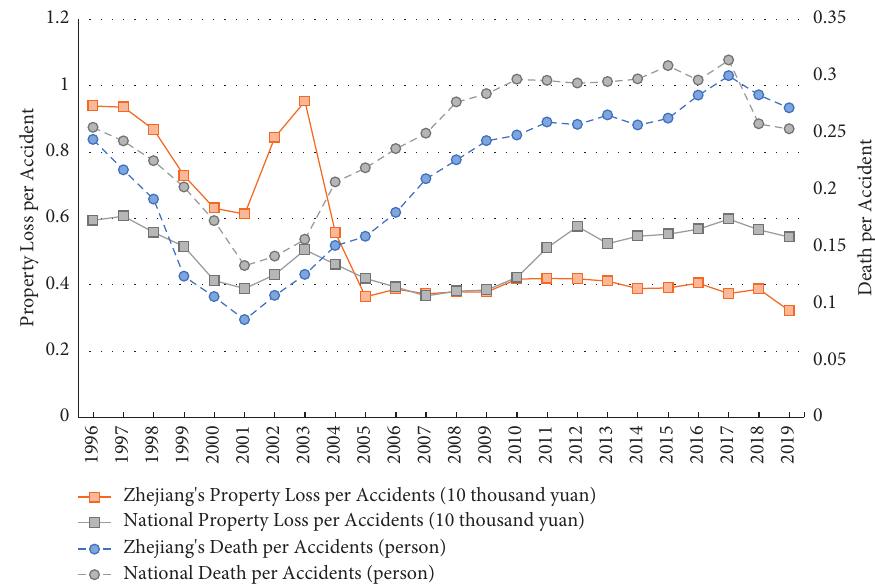
Figure 4: Comparison of death number and property loss per accident between the national average and Zhejiang